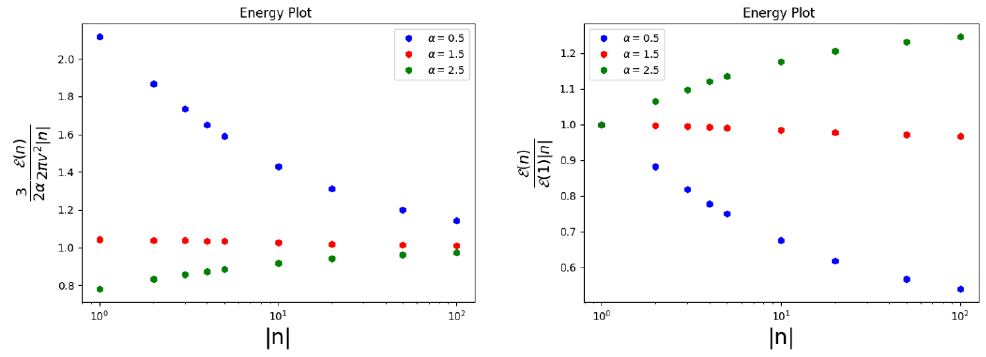
Figure 11 . The scaling of the energy of the n -vortex with j n j and (cid:11) , with sextic potential.